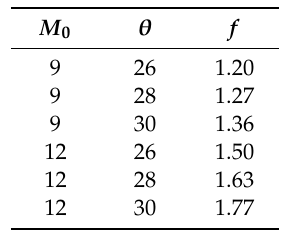
Table 2. Degree of overdrive f for di ff erent inflow Mach number M 0 and wedge angle θ